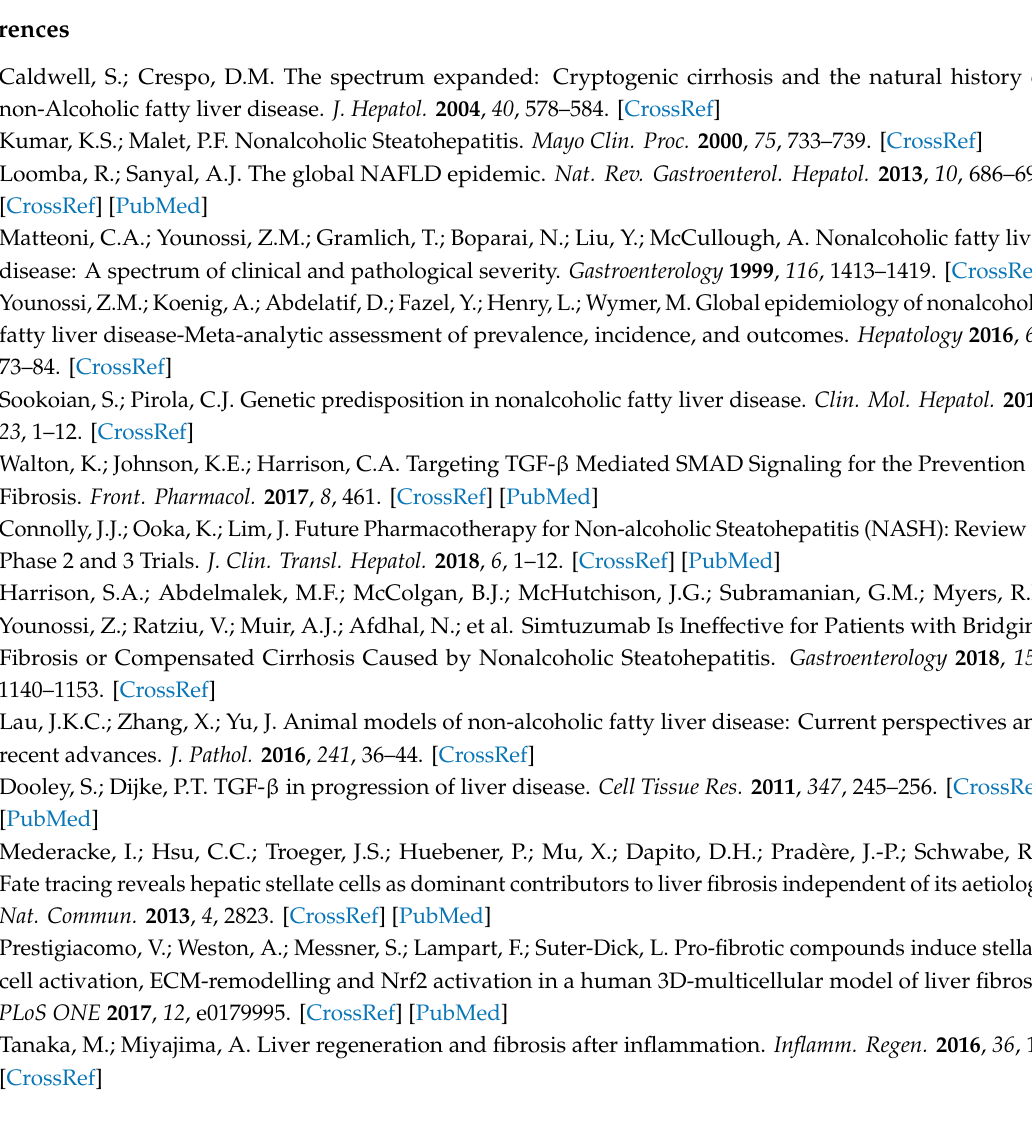
Supplementary Figure S1: Titration of the NPC incorporation. Supplementary Figure S2: Expression of NPC markers. Supplementary Figure S3: Expression of macrophage-lineage markers. Supplementary Figure S4: Cell viability in response to various stimuli. Supplementary Figure S5: TGF β signalling during the formation of co-culture. Table S1: Anti-NASH drugs, Table S2: TaqMan assay probes, Table S3: Immunohistochemistry